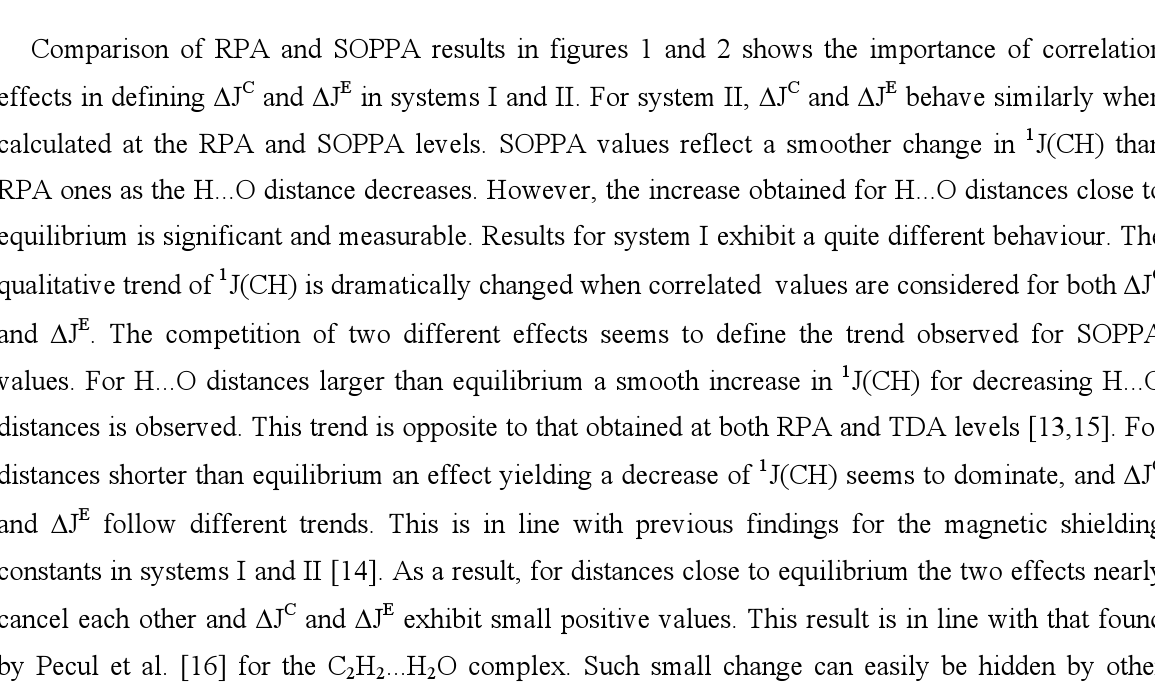
Figure 2. Change in 1 J(CH) for the CH field, ∆ J E , with respect to 1 J(CH) for the isolated CH r(H...O). - (cid:88) - ∆ J E (RPA), - (cid:81) - ∆ J E (SOPPA), - (cid:86) - ∆ J C (RPA), - (cid:79) - ∆ J C (SOPPA). The dotted line indicates the equilibrium